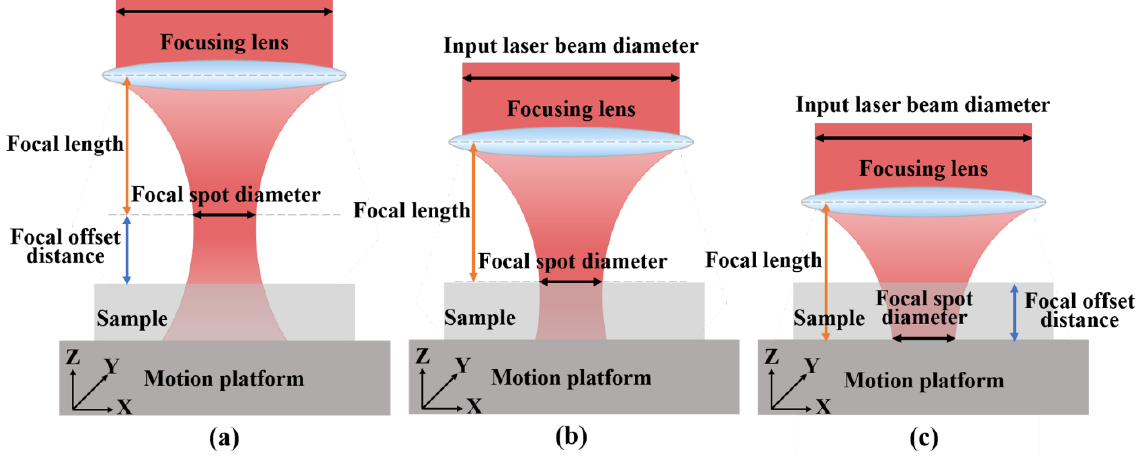
Figure 12. The schematic diagrams of three defocus situations of laser beam. ( a ) Positive defocus, ( b ) zero defocus and ( c ) negative defocus.